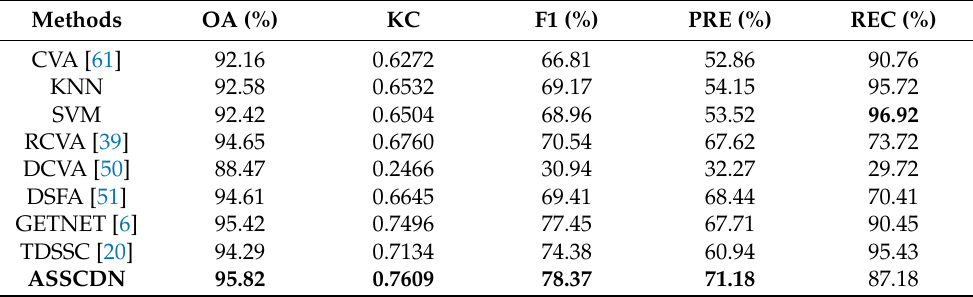
Table 4. Quantitative comparison results of various methods applied on the River dataset.